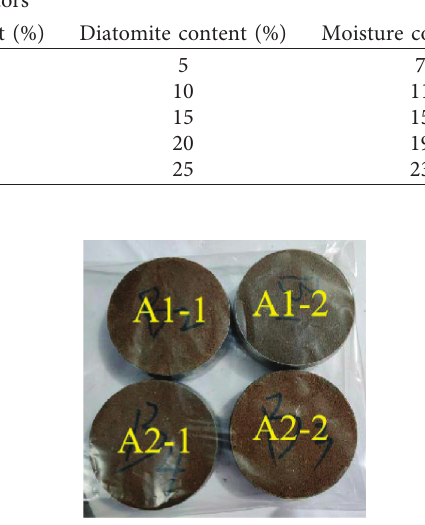
Figure 2: Similar material